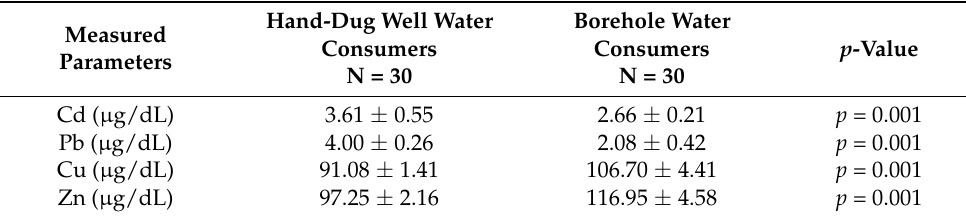
Table 4. Comparison of Blood Cd, Pb, serum Cu and Zn levels in Hand-dug Well and Borehole Water Consumers.